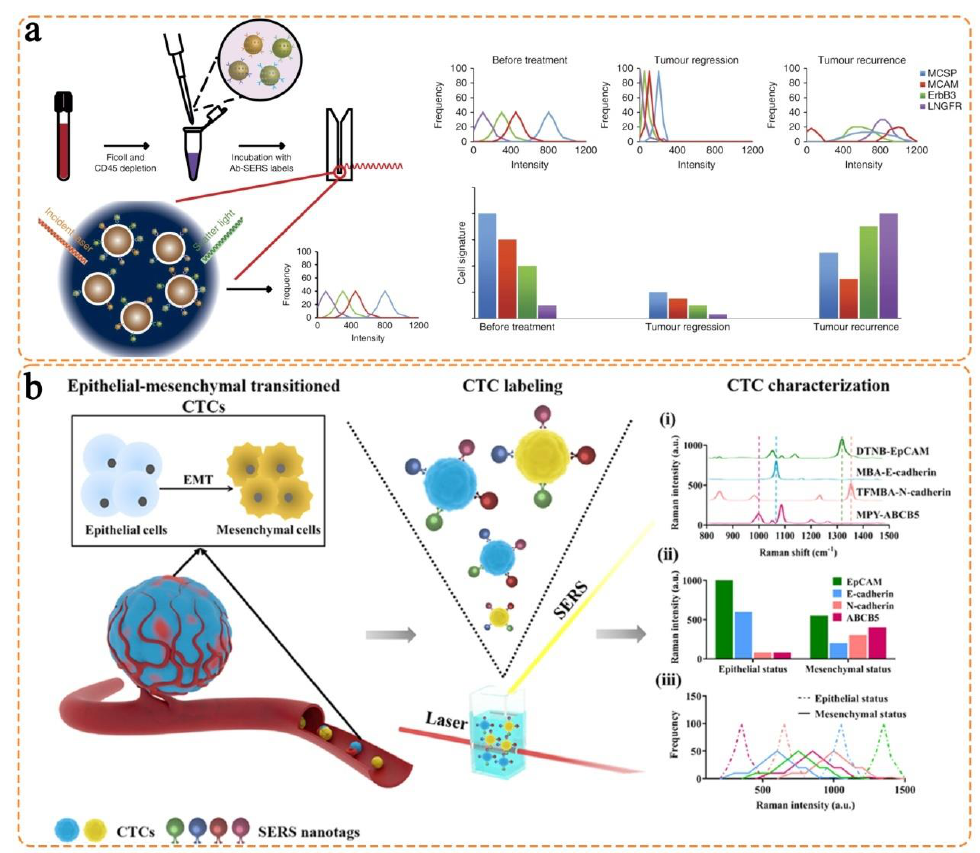
Figure 3. Gold nanosphere-based SERS nanotags for multi-biomarker detection. ( a ) Profiling of four biomarkers on melanoma CTC surface to monitor patients’ response to drug treatments, which involved Ficoll and CD45 depletion and incubation with Ab-SERS labels for Raman detection. Reproduced with permission [44]. Copyright 2018, Nature Publishing Group. ( b ) Detection of four biomarkers (i.e., EpCAM, E-cadherin, N-cadherin, and ABCB5) on melanoma CTC surfaces to monitor epithelial to mesenchymal transition. Reproduced with permission [45]. Copyright 2021, American Chemical Society.